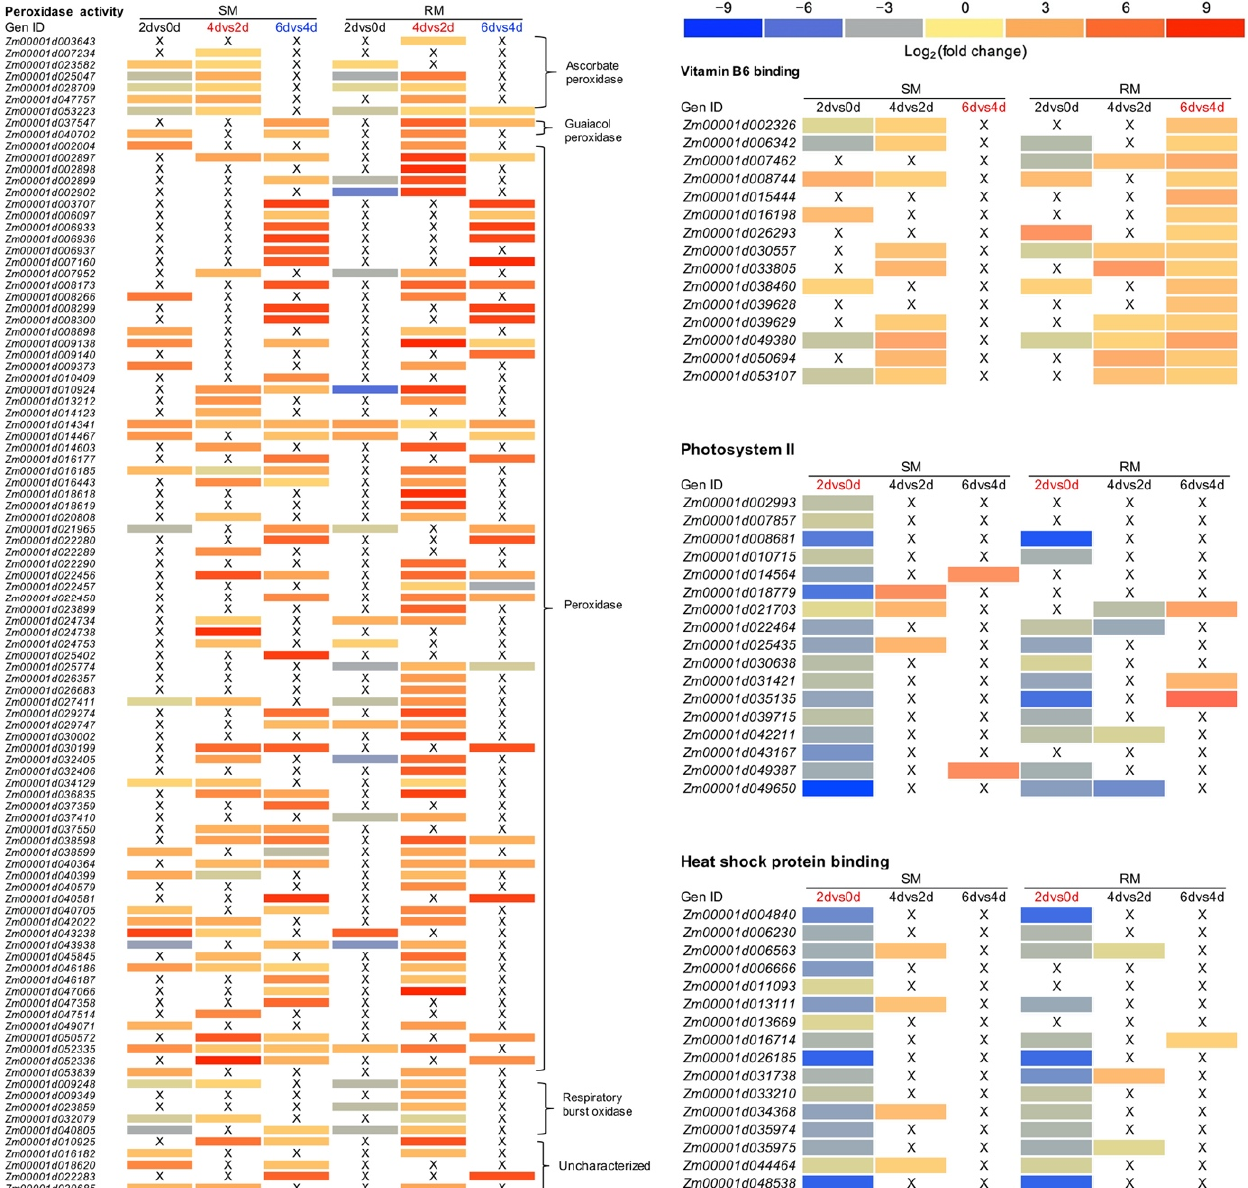
Figure 3. Heat map of selected DEGs enriched in GO terms. Detailed lists of the DEGs are shown in Supplementary Tables S3–S7. SM: low-temperature sensitive maize inbred line; RM: low-temperature resistant maize inbred line. The color code from blue to red suggests the expression level of the DEGs normalized as the log 2 (fold change).